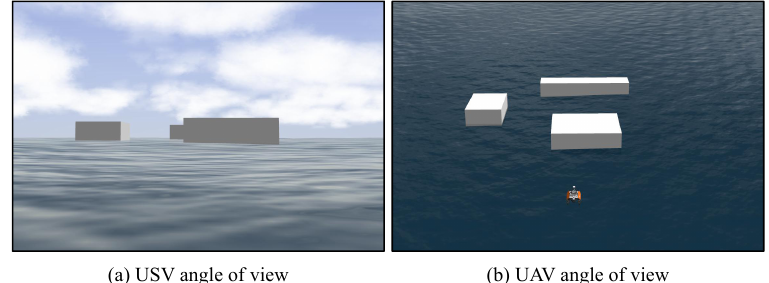
Figure 2. Perspective difference between USV and